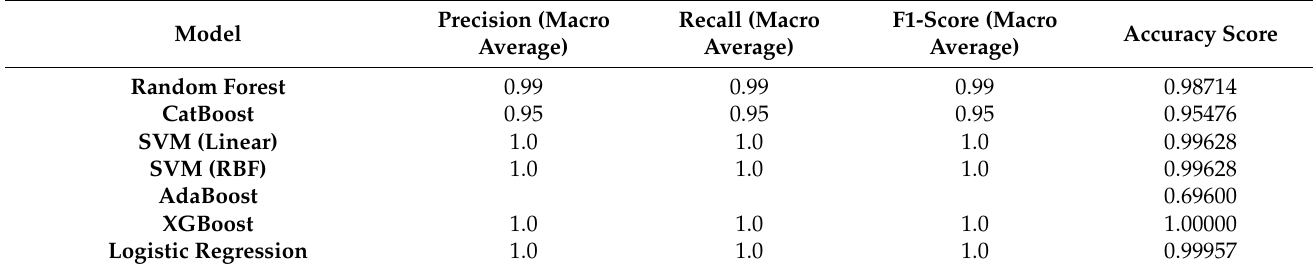
Table 5. Standalone machine-learning models trained on the Arabic MNIST digit